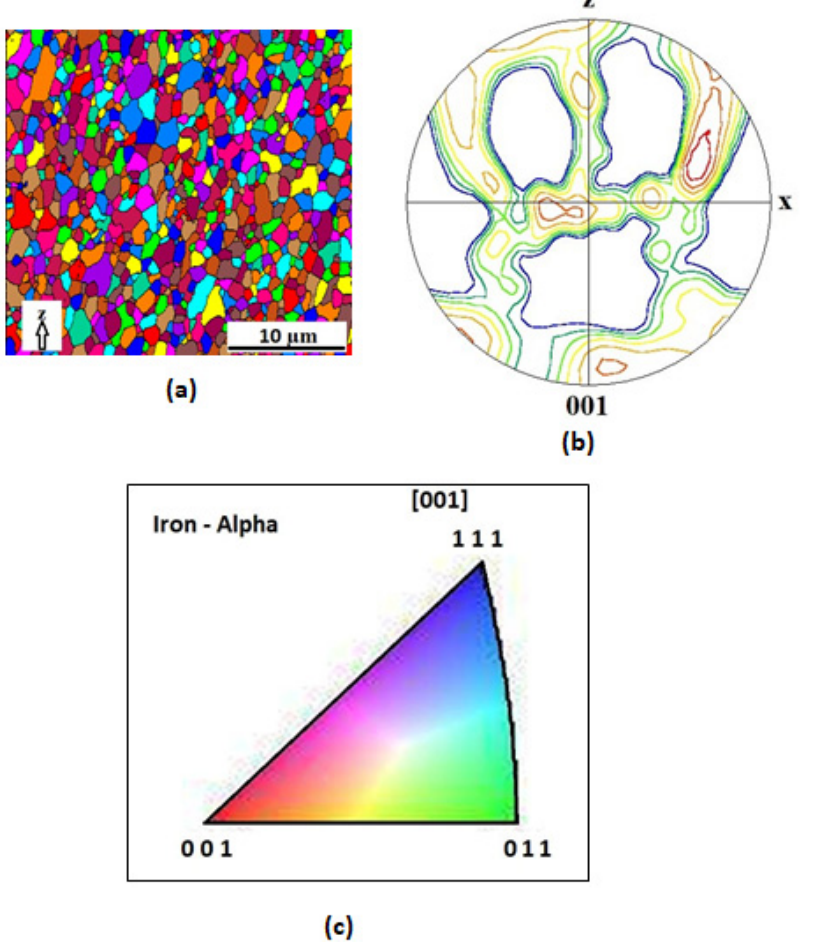
Figure 10. ( a ) orientation colour map of the α and γ phase ( b ) stereographic projection of the 001 poles in the γ phase ( c ) Plane of colour map.